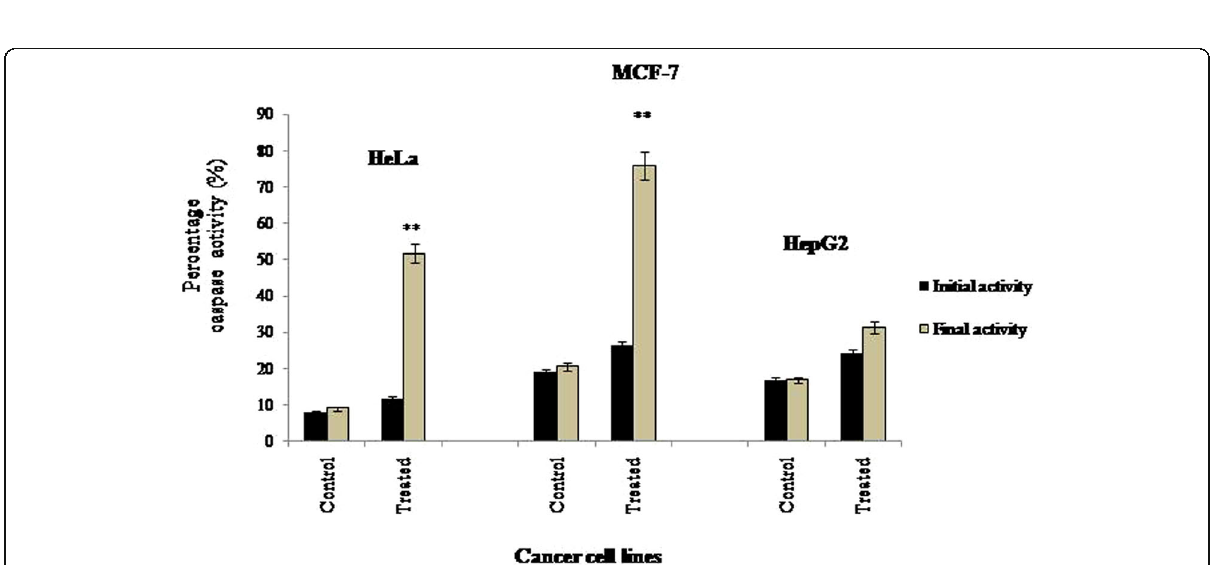
Fig. 6 Caspase activity of the cancer cells. Caspase-3, 7 and 10 activity of CF4-treated HeLa, MCF-7 and HepG2 cells. The values are expressed as mean ± SE. An asterisk denotes significance at p < 0.05 and two asterisks denotes significance at p <